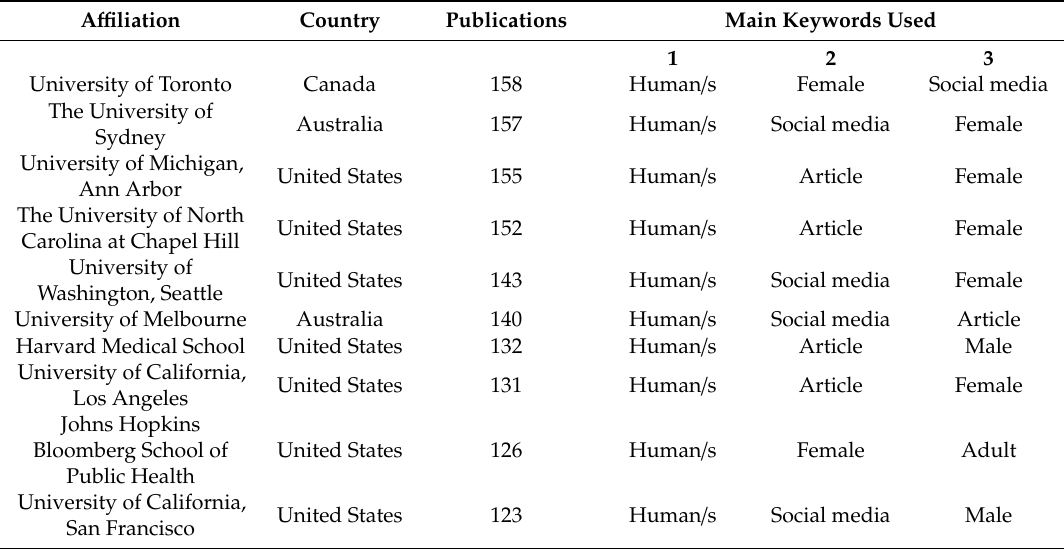
Table 3. Publications and keywords utilized by the top ten international institutions. A ffi liation